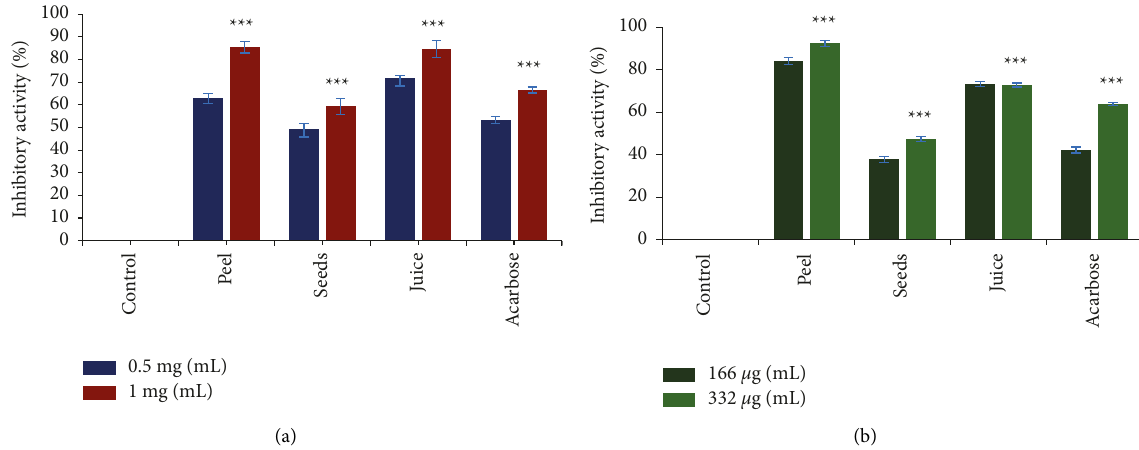
Figure 5: Inhibitory activity of O. dillenii peel, seed and juice ethanolic extracts against pancreatic α -amylase (a) at two different con- centrations (0.5 and 1mg/mL) and intestinal α -glucosidase (b) at two different concentrations (166 and 332 μ g/mL). ∗∗∗ p value < 0.001 as compared to the control. Values are means of three determinations.